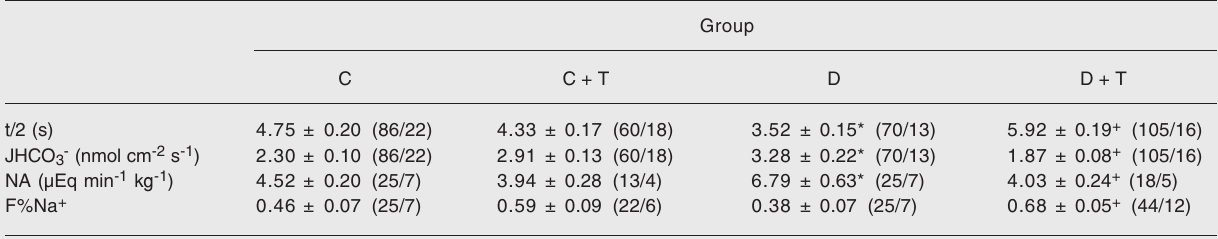
Table 3. Acidification half-time (t/2), bicarbonate absorption flux (JHCO 3- ) in proximal tubules, net acid excretion (NA), and fractional sodium excretion (F%Na + ) in the animal groups